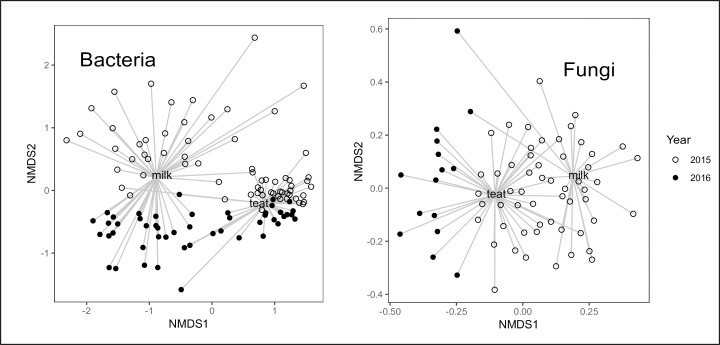
Bi-plot of Bray-Curtis dissimilarity of bacterial and fungal communities of intramammary milk and teat skin pooled across years.Points represent gland samples (n = 114 bacteria, n = 70 fungi) colored by sampling year. Lines represent distance to centroid of sample type. Abundances were transformed as square root prior to analysis.